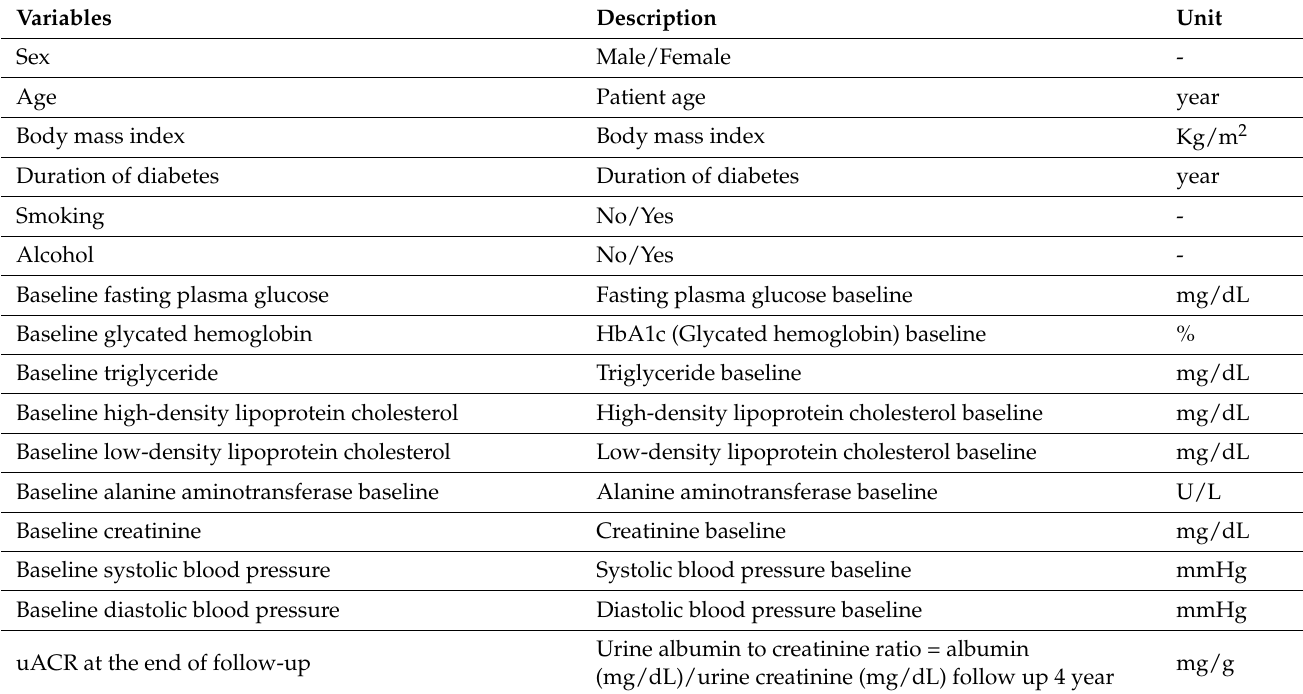
Table 1. Variable